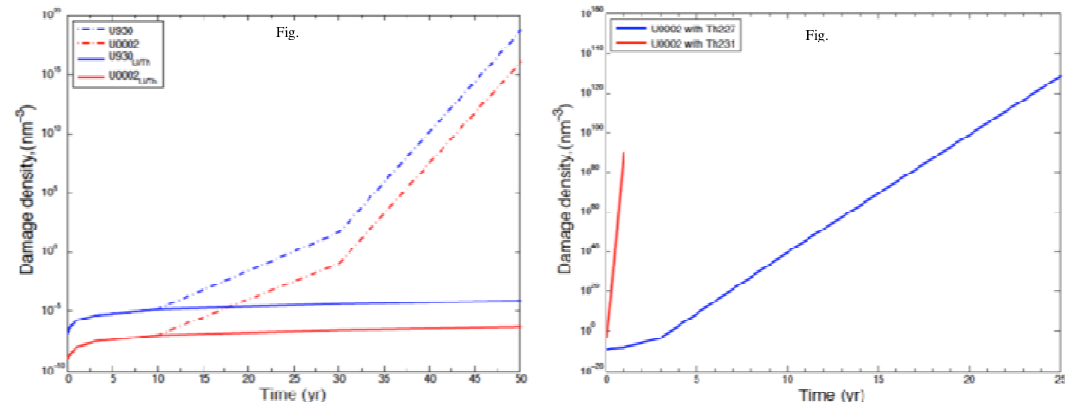
Figure 4. Modeled density of α -recoil tracks: (a) including long-lived daughters, (b) incorporating the decay of 227 Thand 231